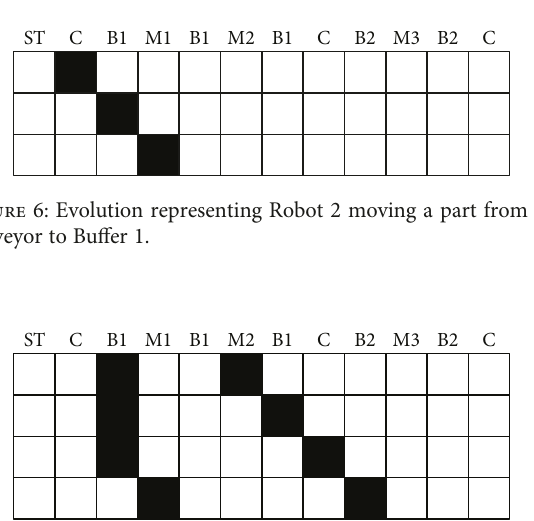
Figure 7: Robot 2 moving a part from Machine 2 to Bu ff er 1 and then to the conveyor, while another part in Bu ff er 1 waits until Robot 2 fi nishes the